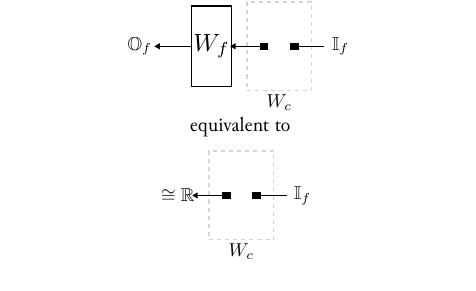
Figure 2: Compositional equality involving constant